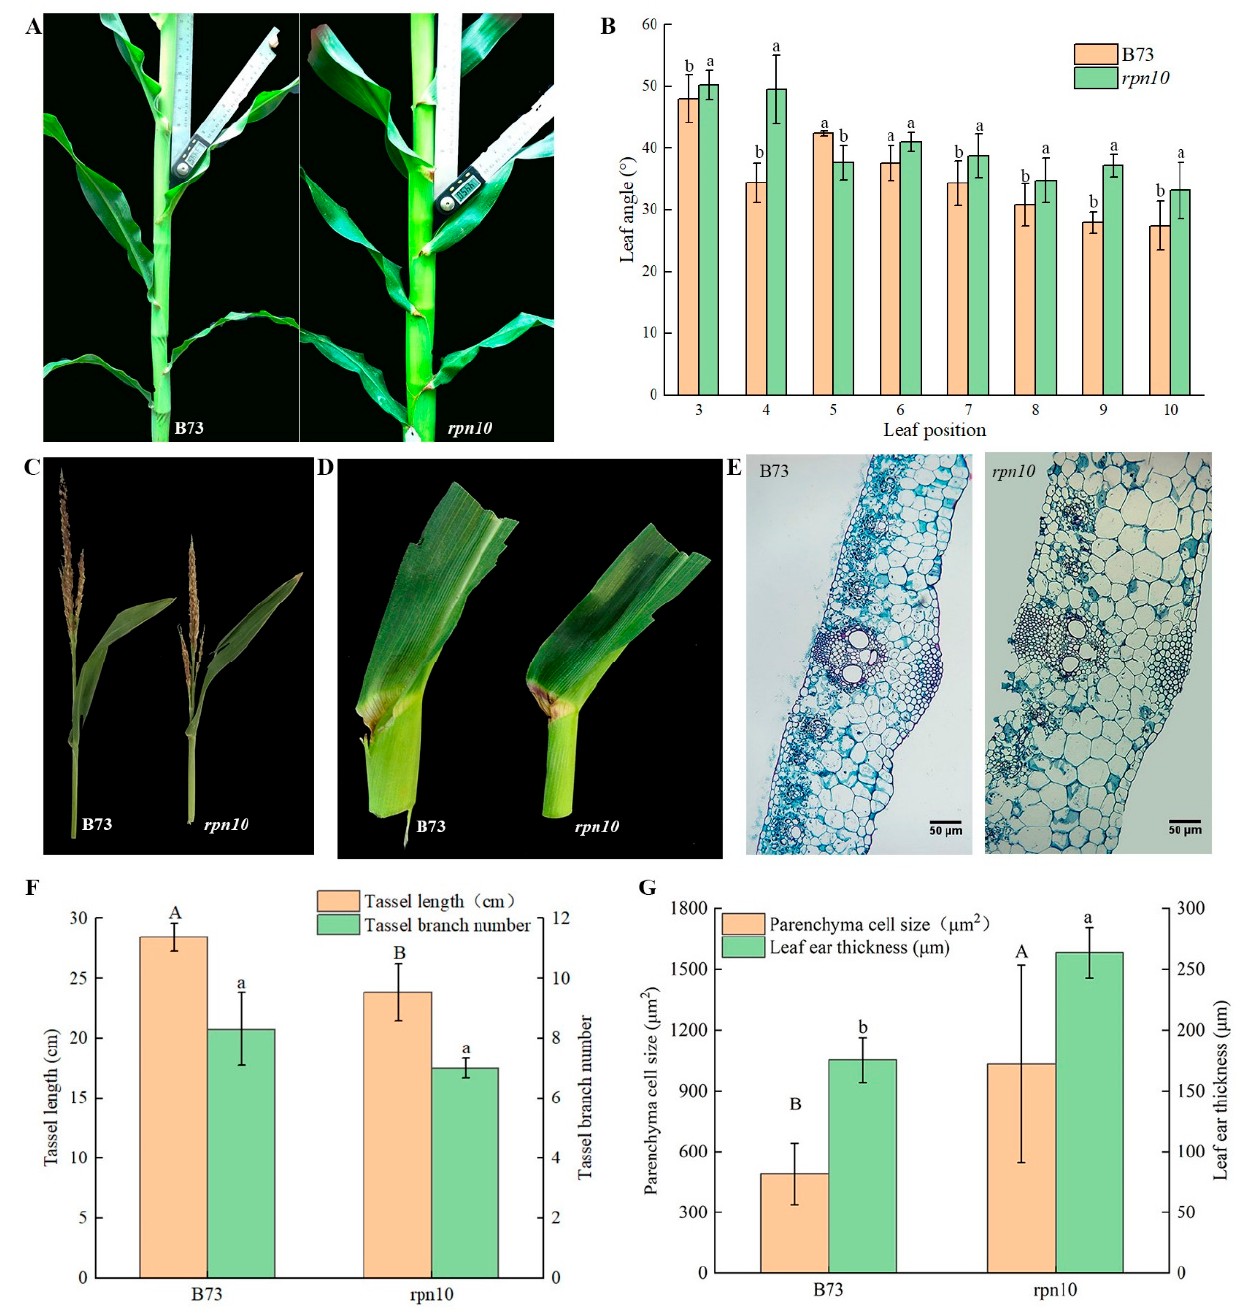
Figure 2. Field phenotype analysis of B73 and rpn10 (A) Field morphology of B73 and rpn10 at the powder-spreading stage; (B) Leaf angle between the third to the tenth leaf of the B73 and rpn10 at the powder-spreading stage; (C) Field performance of B73 and rpn10 tassels; (D) B73 and rpn10 leaf ear morphology at the loosening stage; (E) Cross-section of leaf ear cytology at the pollen stage B73 and rpn10 ; (F) Tassel length and branch number of B73 and rpn10 tassels; (G) Parenchyma cell size and thickness of B73 and rpn10 leaf ear, Bars = 50 μ m. Note: Different case letters indicate significant difference between different materials, p < 0.05, same blow. Table 1. The investigation on agronomic characters of B73 and rpn10 .